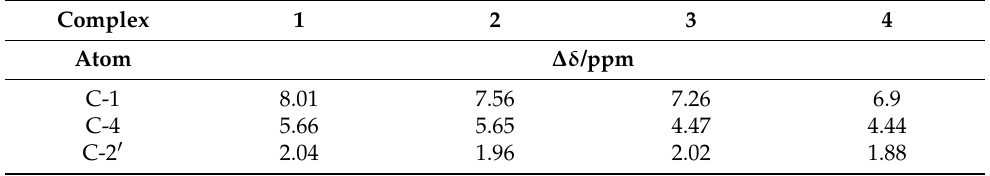
Table 1. The 13 C coordination chemical shifts ∆ δ (ppm) for carbon atoms adjacent to ONO donors.